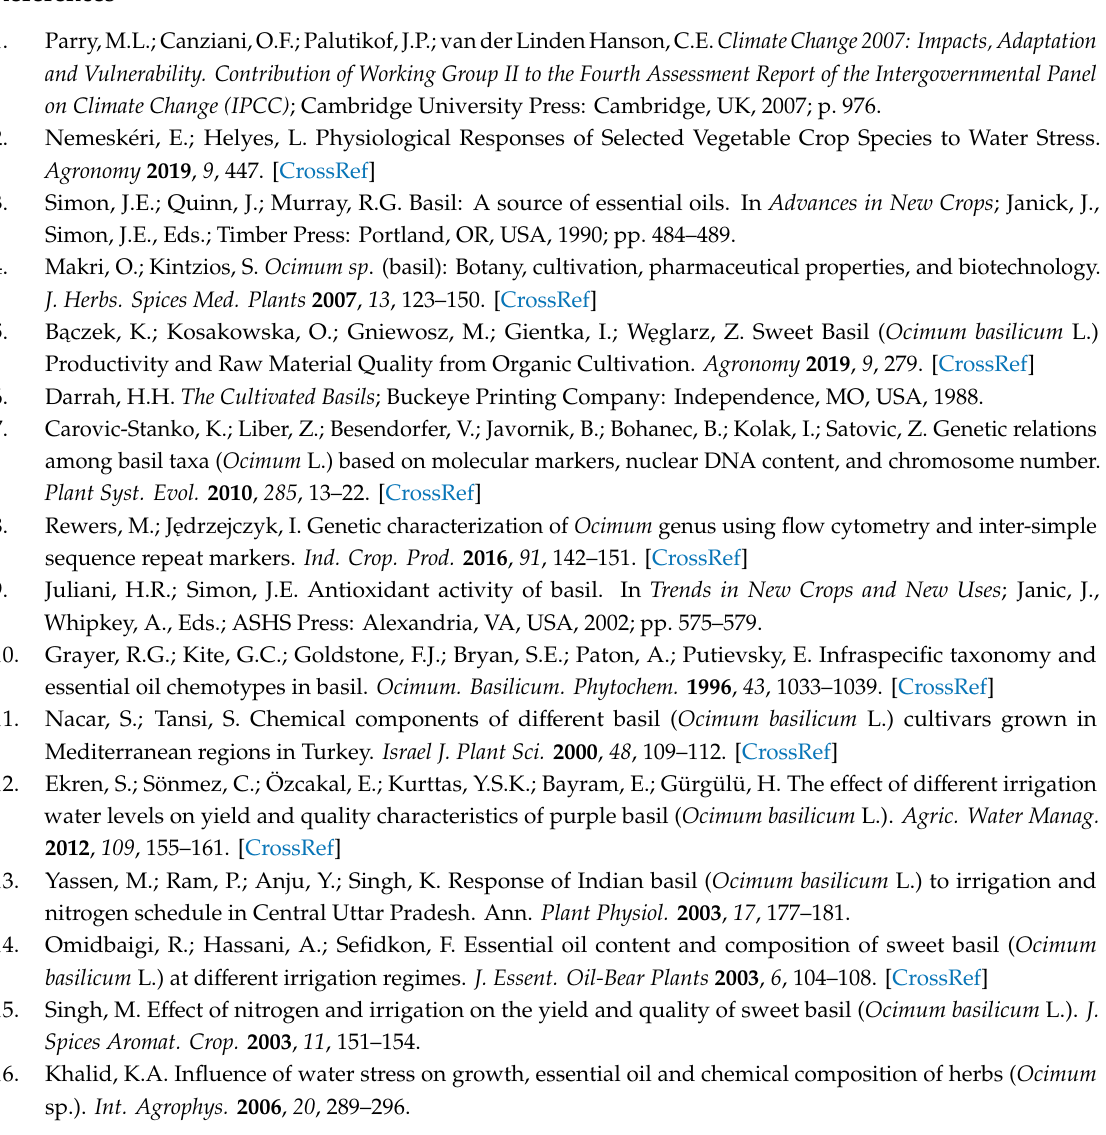
Table S1: E ff ect of cultivar and irrigation on fresh and dry weight, dry weight of leaves, flowers and stems and ratio of leaves and flowers to stems at the beginning of flowering during the two years (2015 and 2016). Table S2. E ff ect of cultivar and irrigation on fresh and dry weight, dry weight of leaves and flowers, stems and ratio of leaves and flowers to stems at full bloom during the two years (2015 and 2016). Table S3. E ff ect of cultivar and irrigation on fresh and dry weight, dry weight of leaves and flowers, stems and ratio of leaves and flowers to stems at the end of flowering during the two years (2015 and